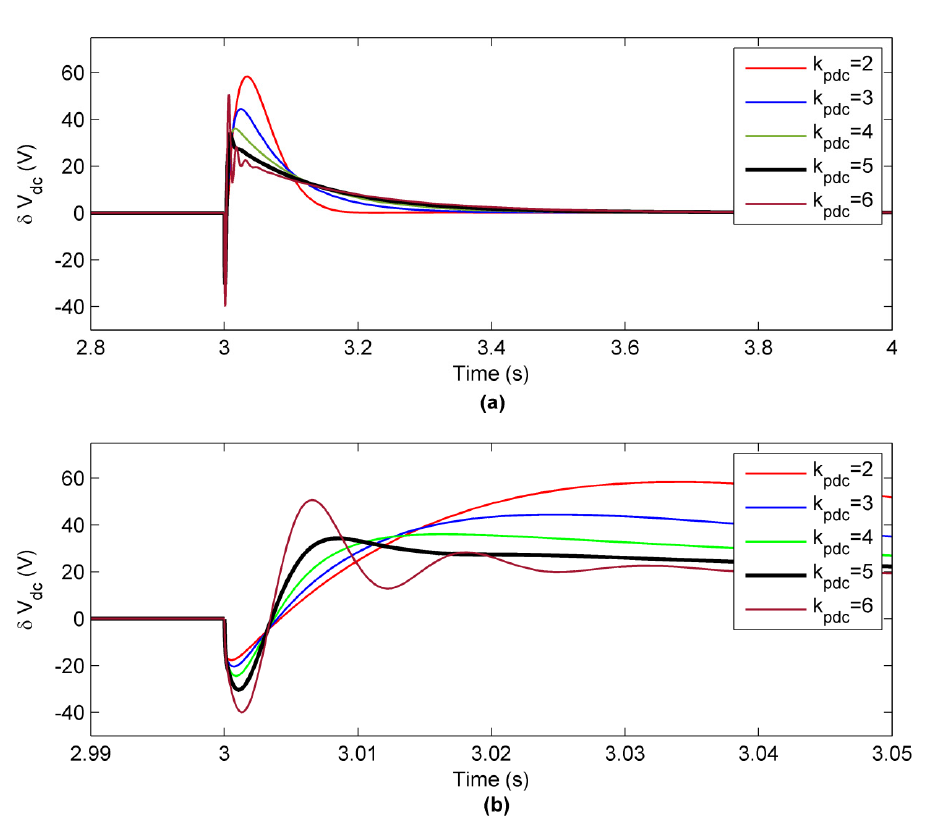
Figure 11. ( a ) The dc-link voltage variation by increasing k pdc in a 50% voltage drop in the grid; and ( b ) zoom of starting time of variation.